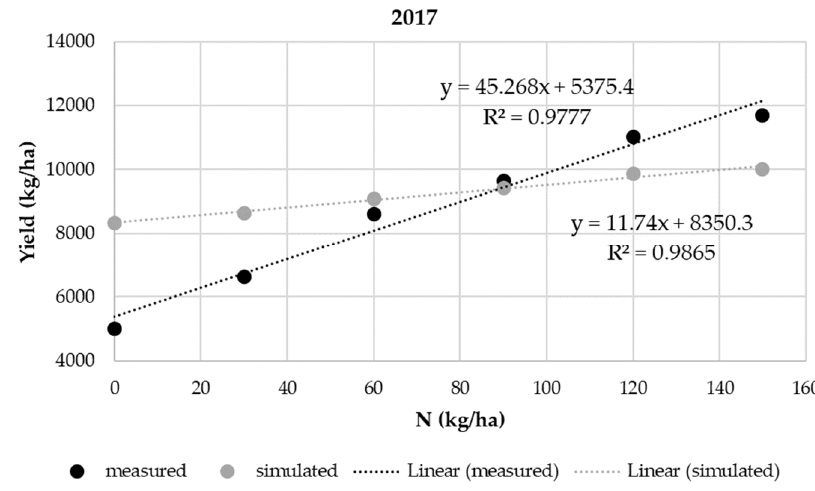
Figure 3. Comparisons between simulated and measured maize grain yield (2017).